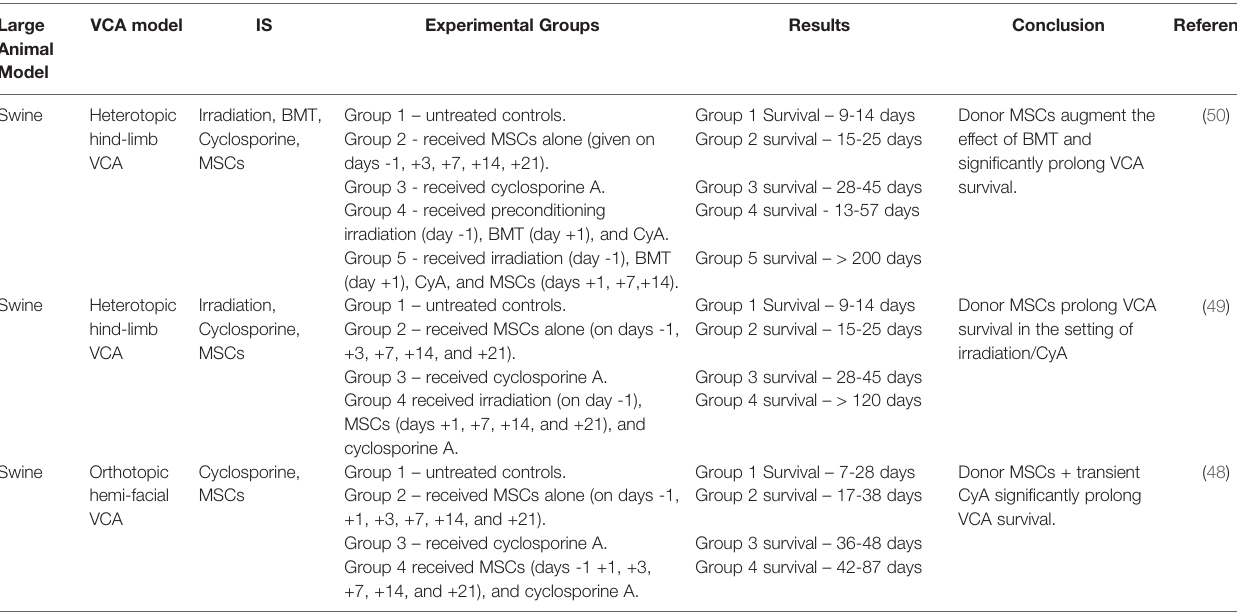
TABLE 3 | Cellular